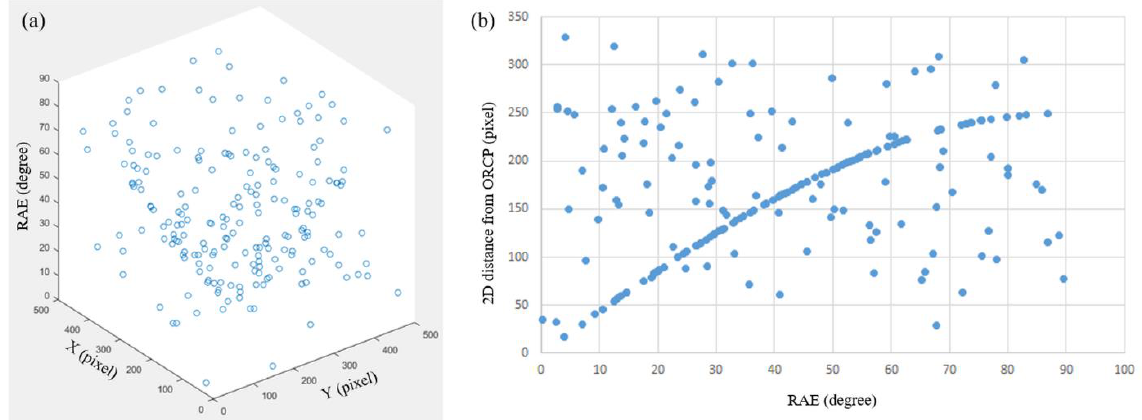
Figure 10. ( a ) 3D dataset distribution diagram. ( b ) Data set distribution diagram expressed in RAE and the distance between ORCP and each data on the xy-plane.